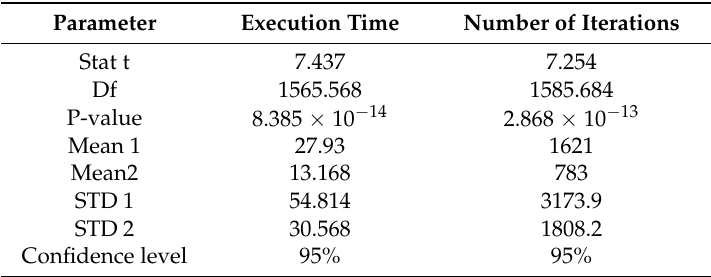
Table 5. T-test results.